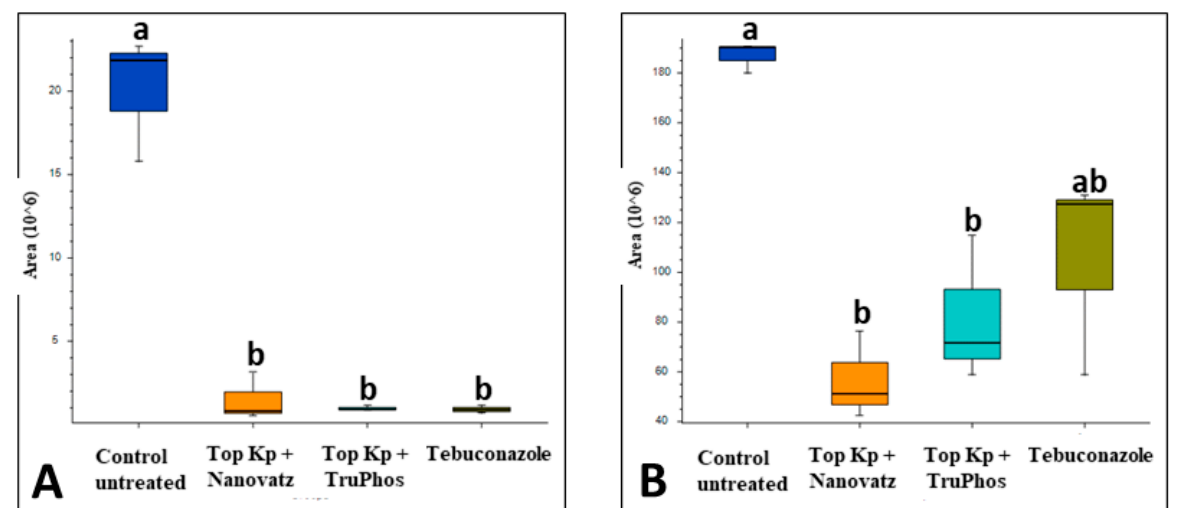
Figure 3. Relative amounts (peak area) of metabolites that were up-produced in grape skins of cv. Riesling untreated control vines, compared to vines treated with five foliar spays (starting at 14 April until 3 June) of the fungicide Folicur (tebuconazole) 0.02%, or the fertilizers Top Kp+ 1% plus Nanovatz 0.1%, Top KP+ 1% plus TruPhos 0.25%. Analysis was conducted using LC–MS/MS. ( A ) Cis-Resveratrol, ( B ) Catechin 3-O-gallate. Different letters represent significant differences ( p < 0.05, Tukey-Kramer HSD test).